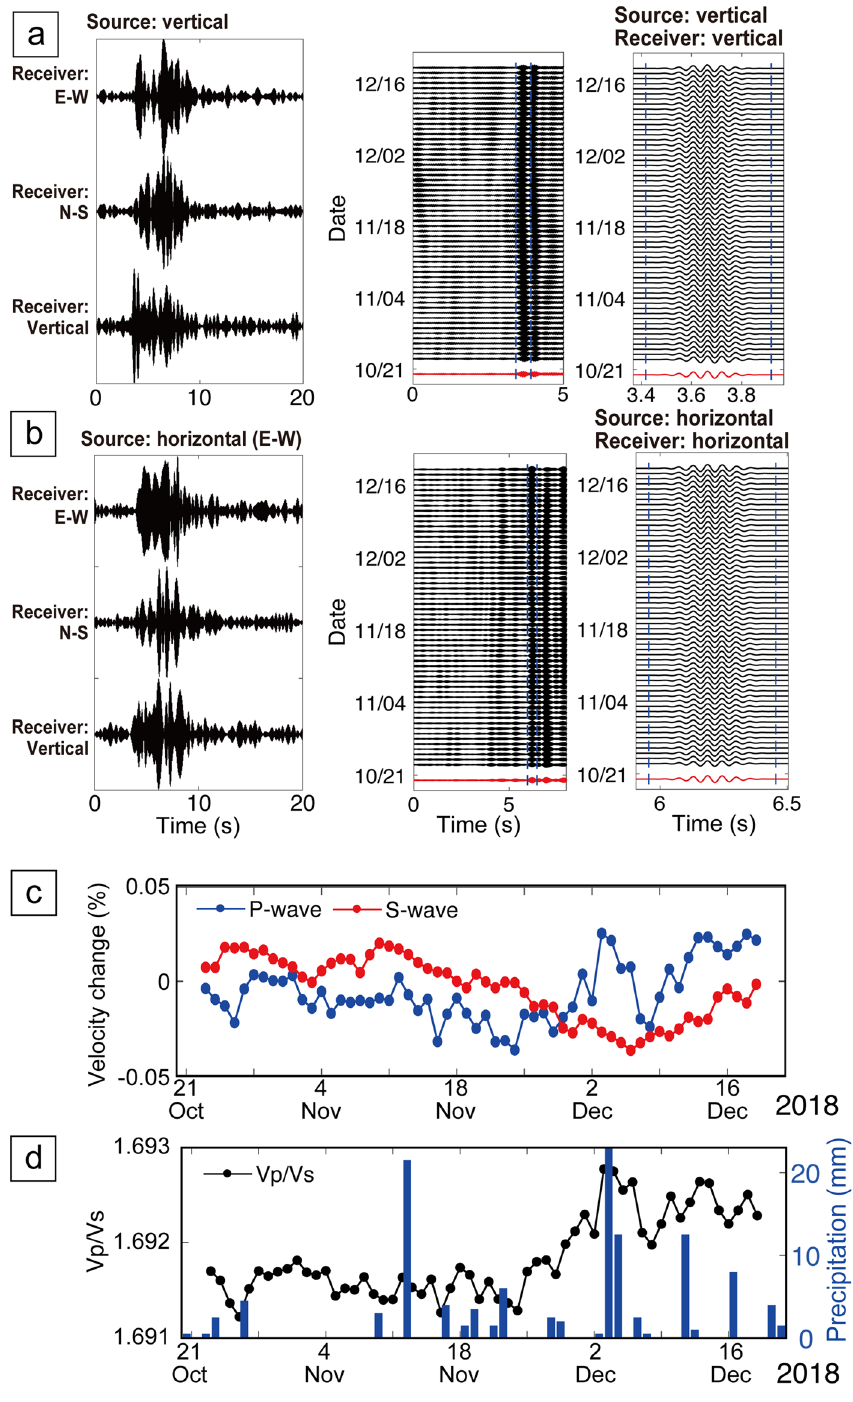
Figure 7. Monitoring results derived from the Hi-net seismometer ~ 14.6 km from the source system. ( a ) Transfer functions derived from vertical source motion (left) and its temporal variation (middle and right). The right panel shows the enlarged waveform close to the first arrival. ( b ) Transfer functions derived from horizontal source motion and its temporal variation. ( c ) Temporal variation of seismic velocity. ( d ) Temporal variation of V p / V s , and precipitation from rain events recorded in the study